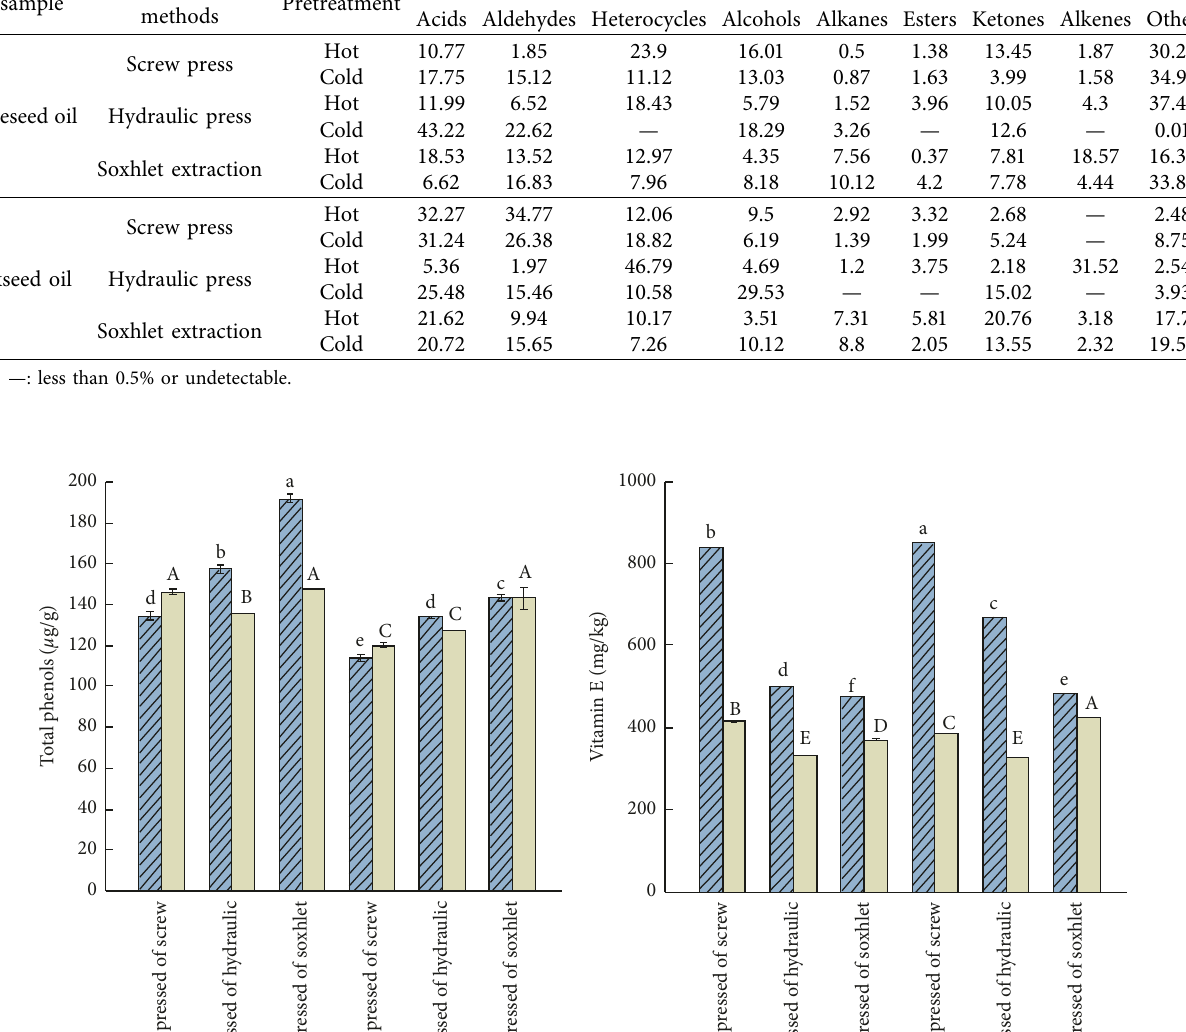
Table 4: SPME-GCMS analysis of volatile compounds in rapeseed and flaxseed oils. Extraction Oil sample